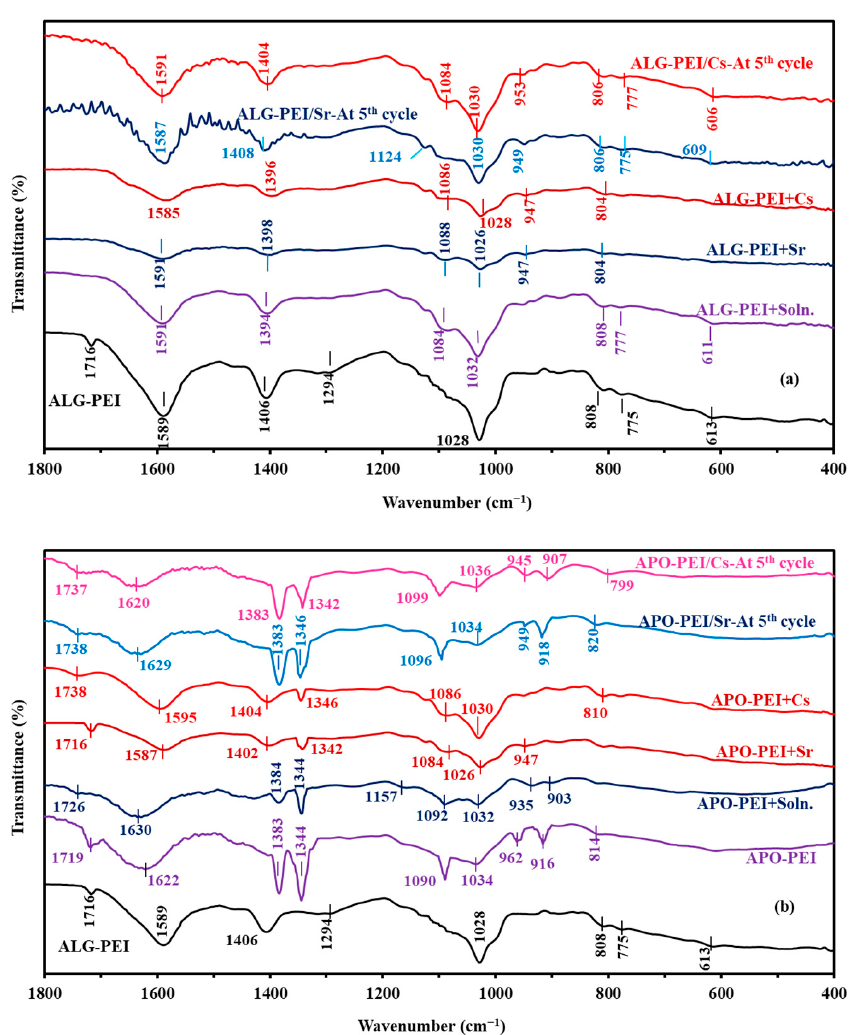
Figure 1. FTIR spectra of ALG-PEI ( a ) and APO-PEI ( b ) sorbents at different stages of use: pristine material, after conditioning at pH 7 (the pH of metal sorption, referenced as “sorbent + Soln.”), after Cs(I) or Sr(II) sorption, after five cycles of sorption/desorption; wavenumber range: 1800–400 cm − 1 .